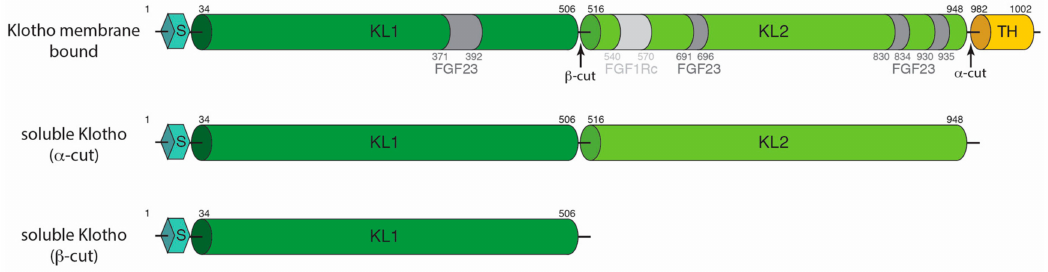
Figure 1. Domain representation of alpha-Klotho. The signal sequence (S), KL1, KL2, and the transmembrane helix (TH) are indicated on the diagram with residue numbering. The interaction with FGF23 and FGFR1c are indicated in the figure in dark and light grey, respectively. Soluble forms of alpha-Klotho are generated with the α - and β